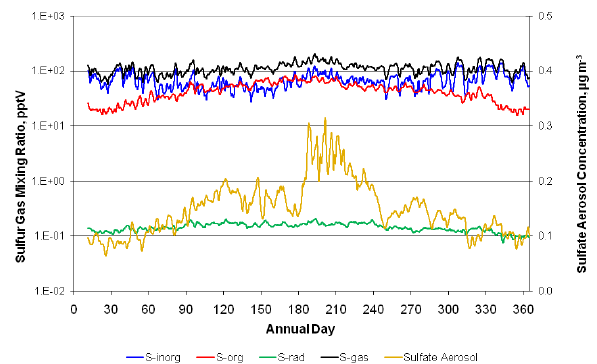
Fig. 3. Grid-averaged time series of various gas and aerosol sulfur species for the natural emissions simulation of 2002. Diurnal noise was removed by applying a 24-hr averaging filter.